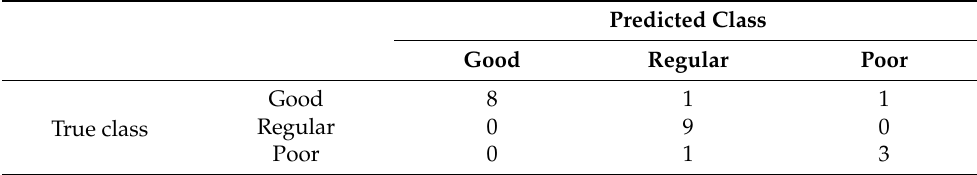
Table 15. Confusion matrix of the proposed meta-learning for the Deep Learning classifier. Predicted Class Good Regular Poor Good 8 1 1 Regular 0 9 0 True class Poor 0 1